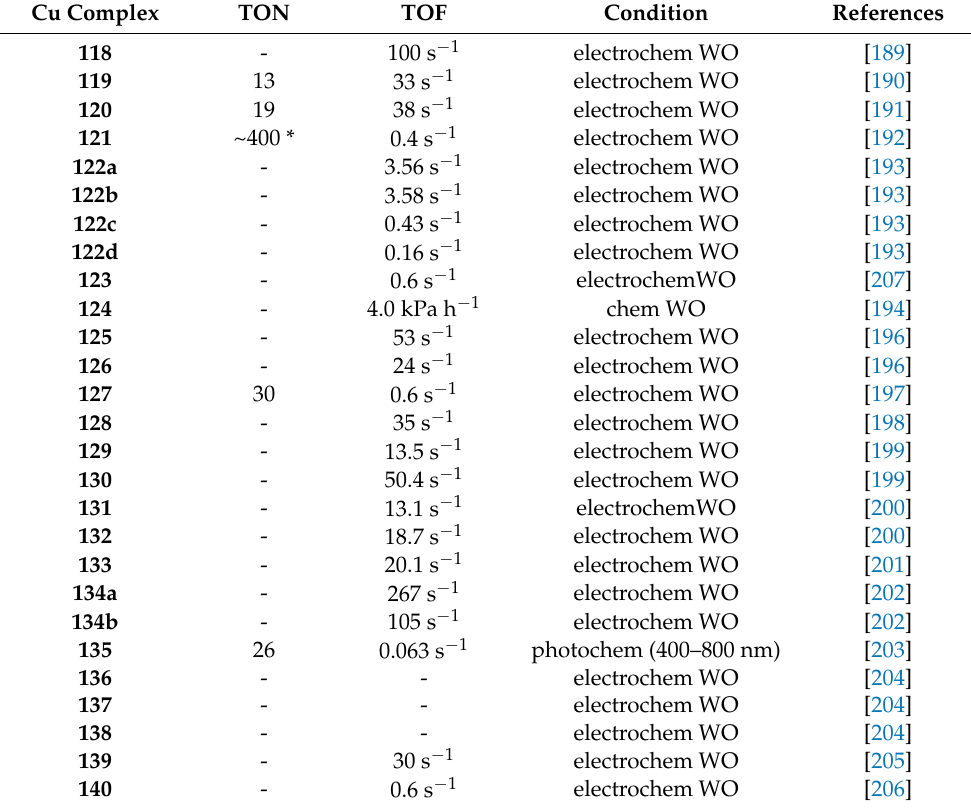
Table 8. Selected catalytic parameters and experimental conditions for Cu catalysts 118–140 for water oxidation. Electrochemical photochemical and chemical water oxidation are abbreviated as ‘electrochem WO’, ‘photochem WO’, and ‘chem WO’, respectively. The TOF values that are not listed in this table are unavailable in literature. Irradiation wavelength for photochemical WO is in